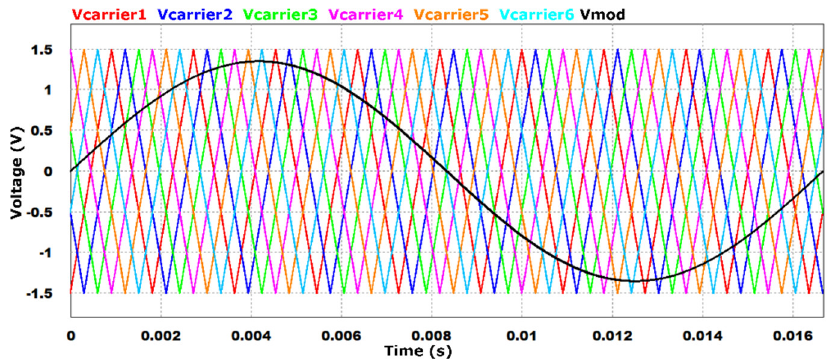
Figure 5. PSC PWM modulation strategy carrier signals.